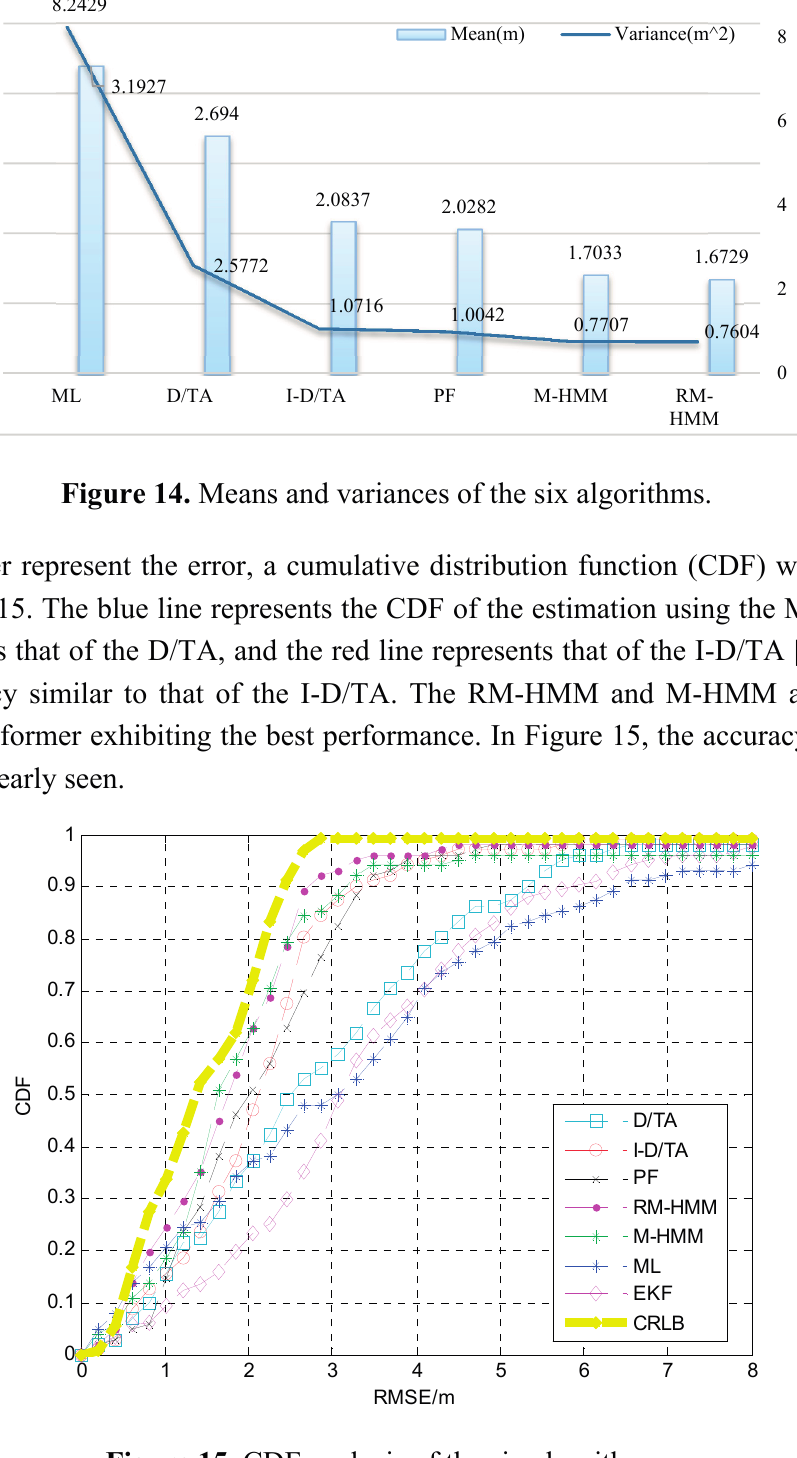
Figure 15. CDF analysis of the six